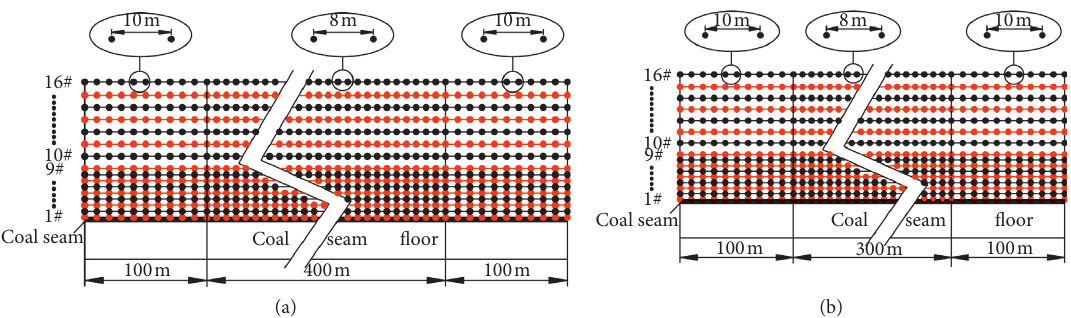
Figure 4: Layout of observation lines in observation surface. (a) Lines on observation surface y � 250m. (b) Lines on observation surface x � 300m.